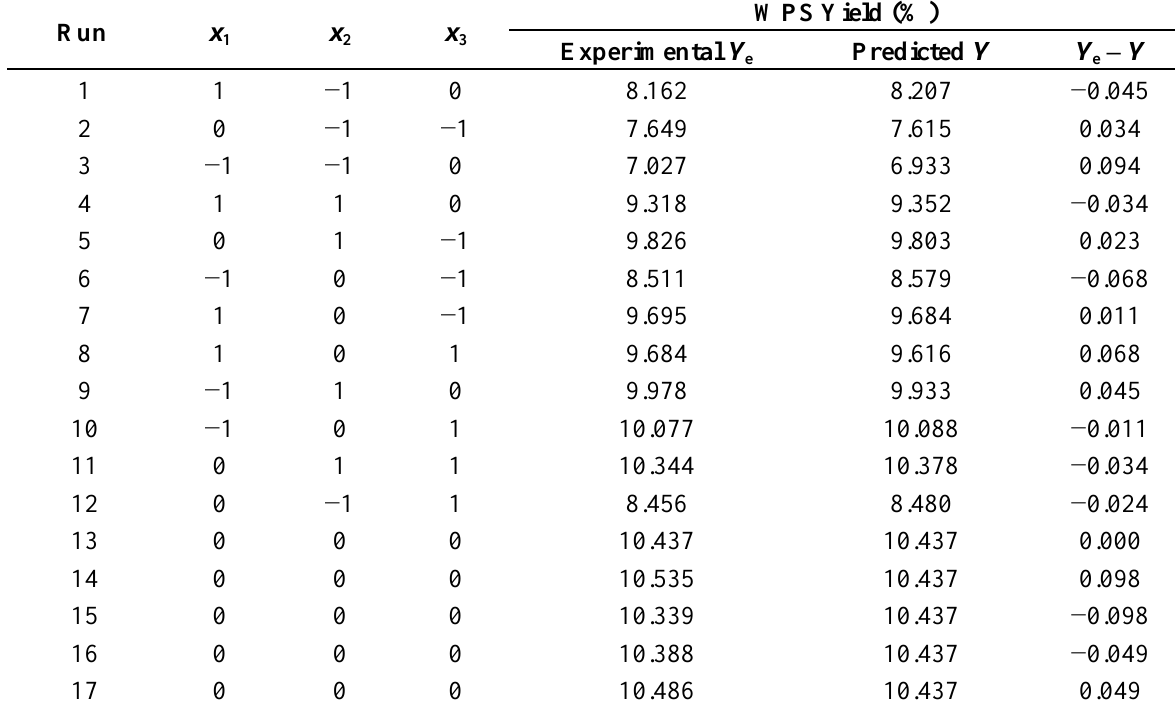
Table 1. Box-Behnken design (BBD) matrix and the response values for water-extracted mycelial polysaccharide (WPS)